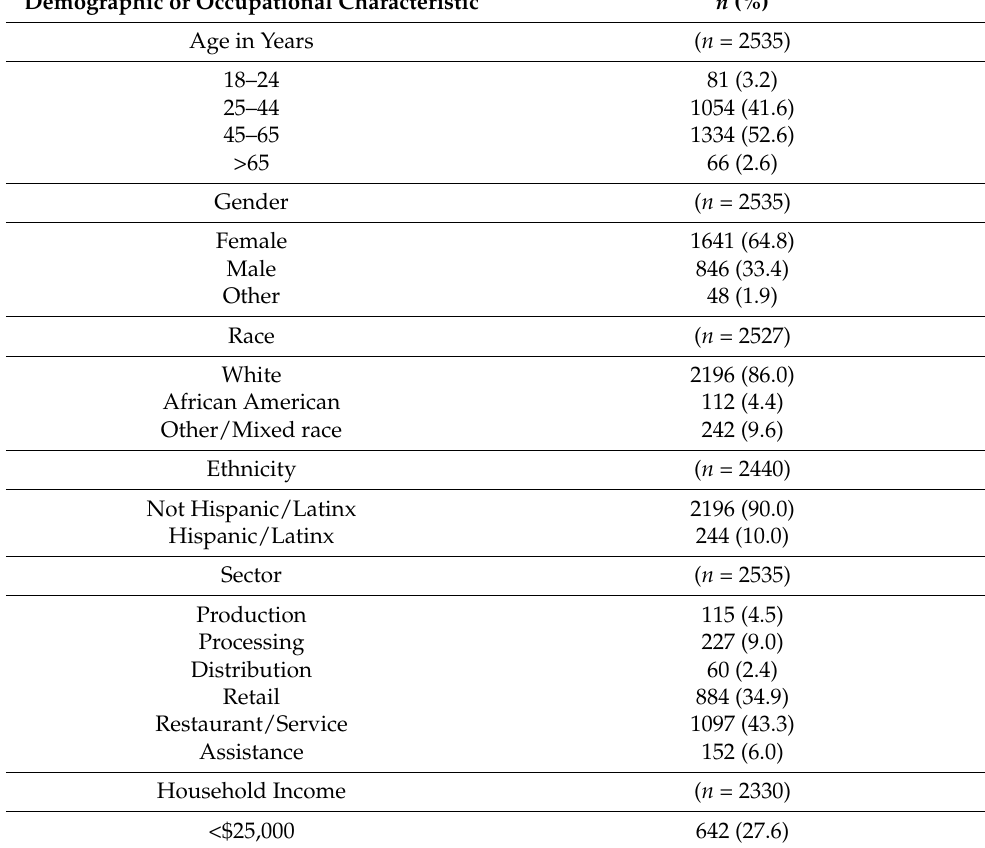
Table 1. Demographic and occupational characteristics for a national United States (U.S.) food system worker cohort during early